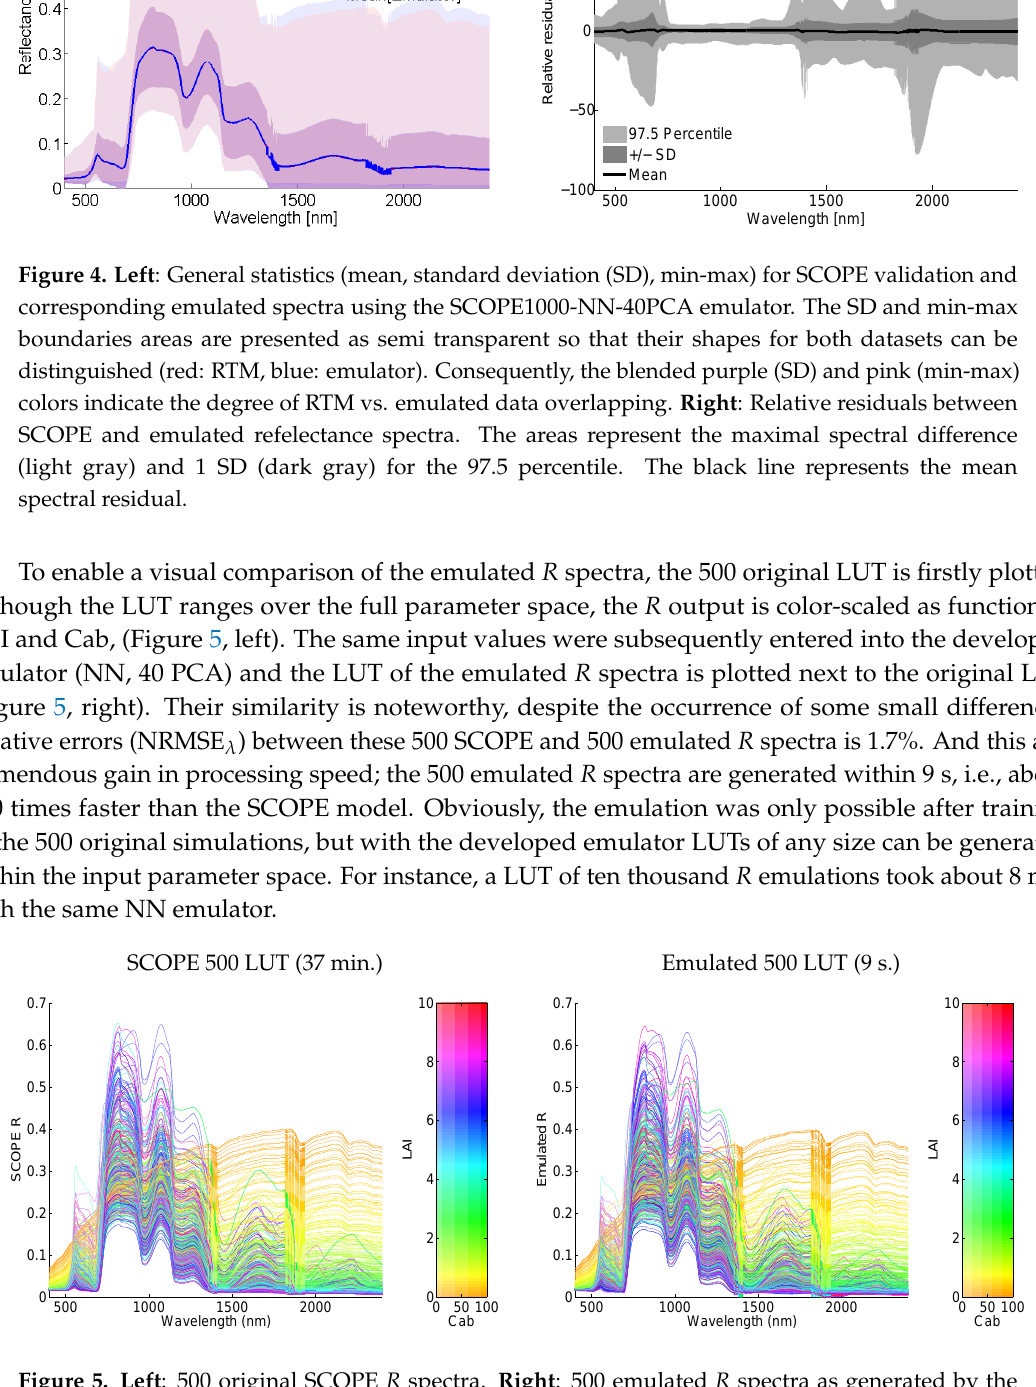
Figure 5. Left : 500 original SCOPE R spectra. Right : 500 emulated R spectra as generated by the SCOPE500-NN-40PCA emulator. Processing time for the generation of the 500 LUT is added on